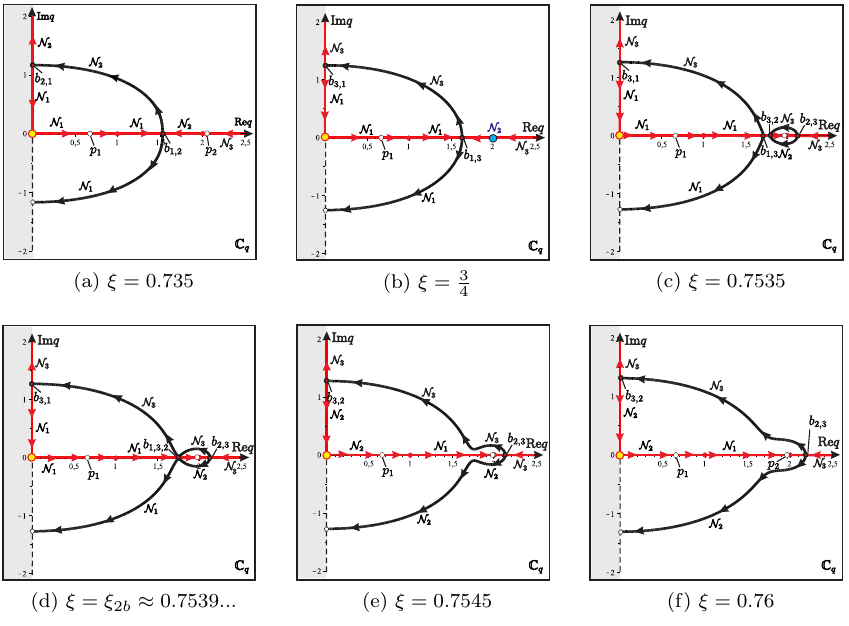
Figure 9. Spectrum Curves for various parameter ξ